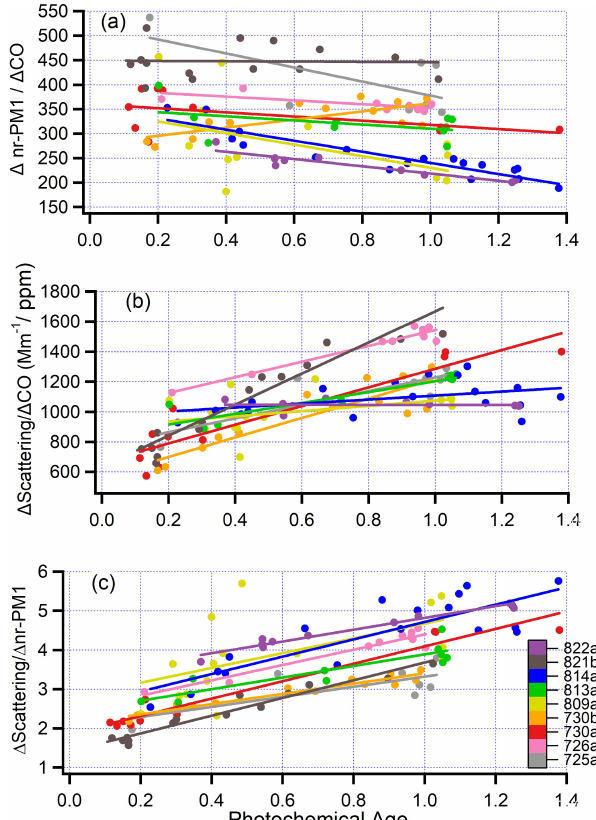
Figure 10. (a) nr-PM1, normalized by CO (µg/m 3 aerosol per ppm CO) as a function of photochemical age for nine pseudo-Lagrangian flights. Photochemical age for flights 809a and 813a has been deter- mined from the relation between distance and age shown in Fig. 2. All variables are excess values with background subtracted. Each data point is a plume transect. Straight lines are ordinary least squares linear fits for each flight. (b) Scattering at 550nm normal- ized by CO as a function of photochemical age for nine flights. (c) Mass scattering efficiency (m 2 g − 1 ) at 550nm as a function of photochemical age for nine